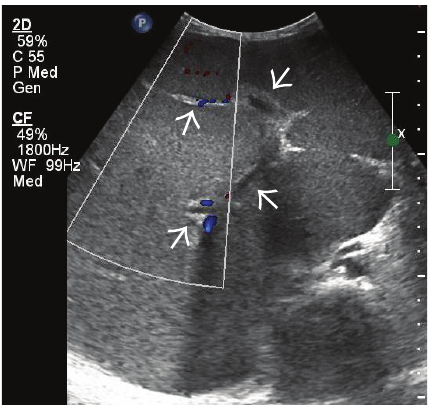
Figure 2: Gray-scale US image demonstrating homogeneously hypoechoic and bulbous liver with chinked portal venous radicals (arrows) in a patient with fulminant